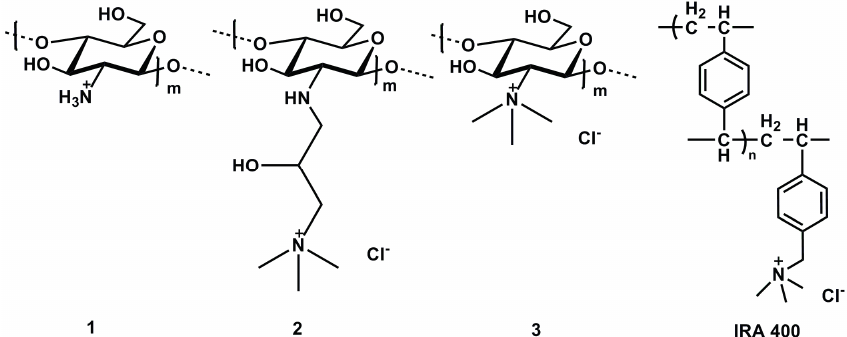
Figure 2. The structures of chitosan ( 1 ), 3-trimethylammonium-2-hydroxypropyl- N -chitosan chloride (CHI-Q188) ( 2 ), N , N , N -trimethyl chitosan chloride (TMC) ( 3 ) and Amberlite IRA 400